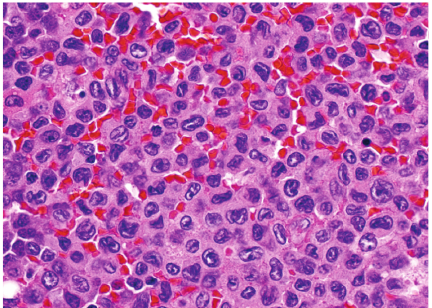
Figure 3: A high power view of the pale areas in Figure 1 showing tumor cells with folded, cleaved, and kidney-bean shaped nuclei.